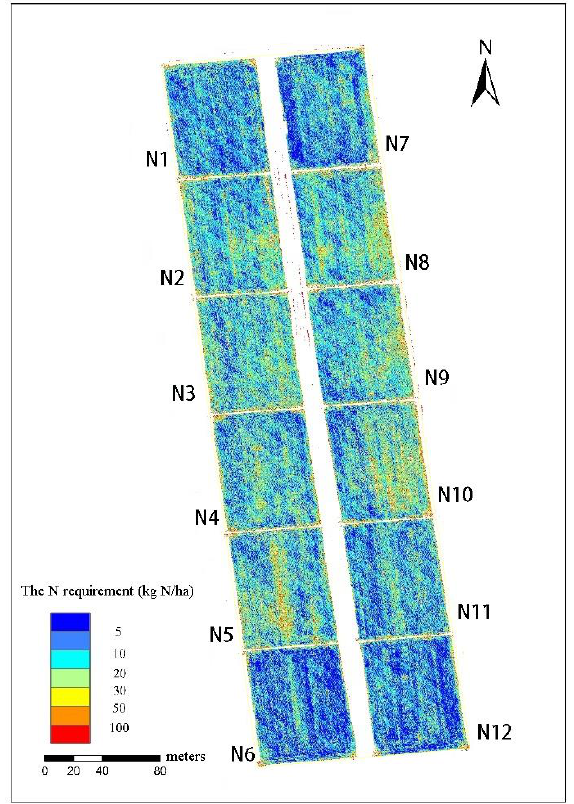
Figure 6. The recommended fertilizer prescription map made using improved NFOA based on UAV data in the experimental plot b.